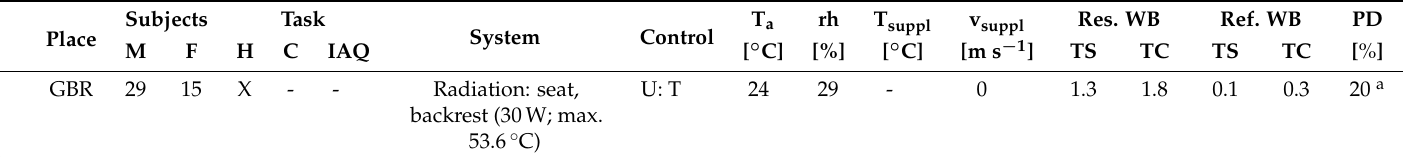
Table A3. Personal climatization systems applying temperature-controlled and ventilated